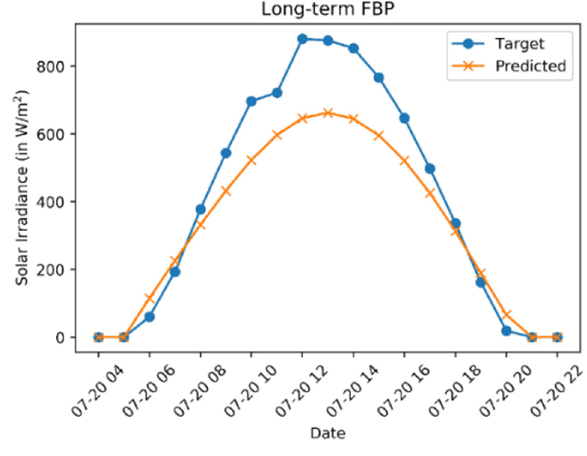
Figure 6. FBP, displaying overprediction in morning and evening and underprediction at noon. For the seasonal adaptation, for every hour of the day within each month (e.g., the 6th hour of every day in January), all values from previous years were collected. The average of these target values for the particular hour was taken for each month, as shown in Figure 7. The same was carried out for the predicted values. Three different versions of average were used: the mean (V1), the median (V2), and the mean of median and mean (V3).